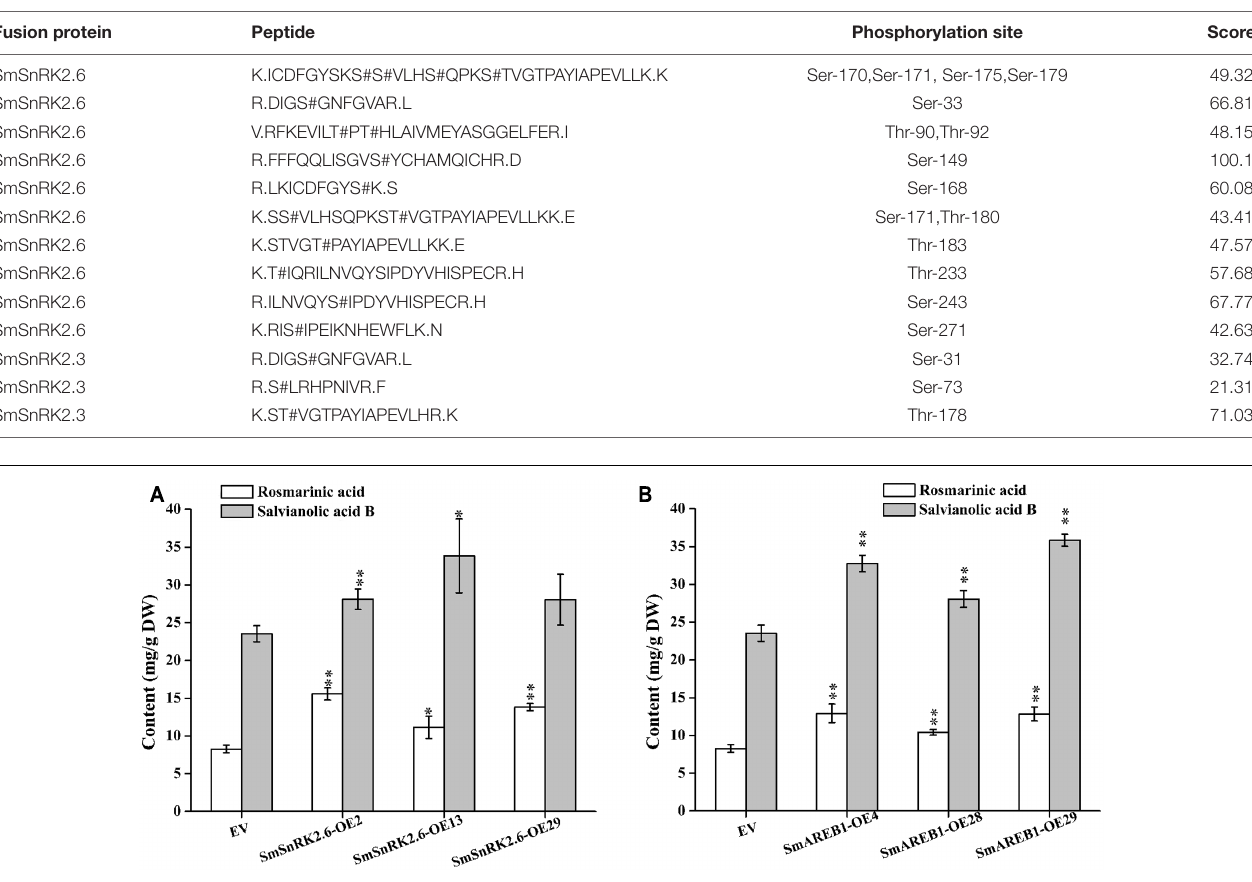
FIGURE 7 | Analysis of RA and Sal B contents in transgenic hairy root lines and empty vector control lines (EV). (A) Contents of RA and Sal B in transgenic lines over-expressing SmSnRK2.6 (SmSnRK2.6-OEs) and EV. (B) Contents of RA and Sal B in transgenic lines over-expressing SmAREB1 (SmAREB1-OEs) and EV. Values are mean ± SD, n = 3. Asterisks indicate significant differences between transgenic lines and EV control, obtained via Student’s t -test ( ∗ P < 0.05, ∗∗ P <